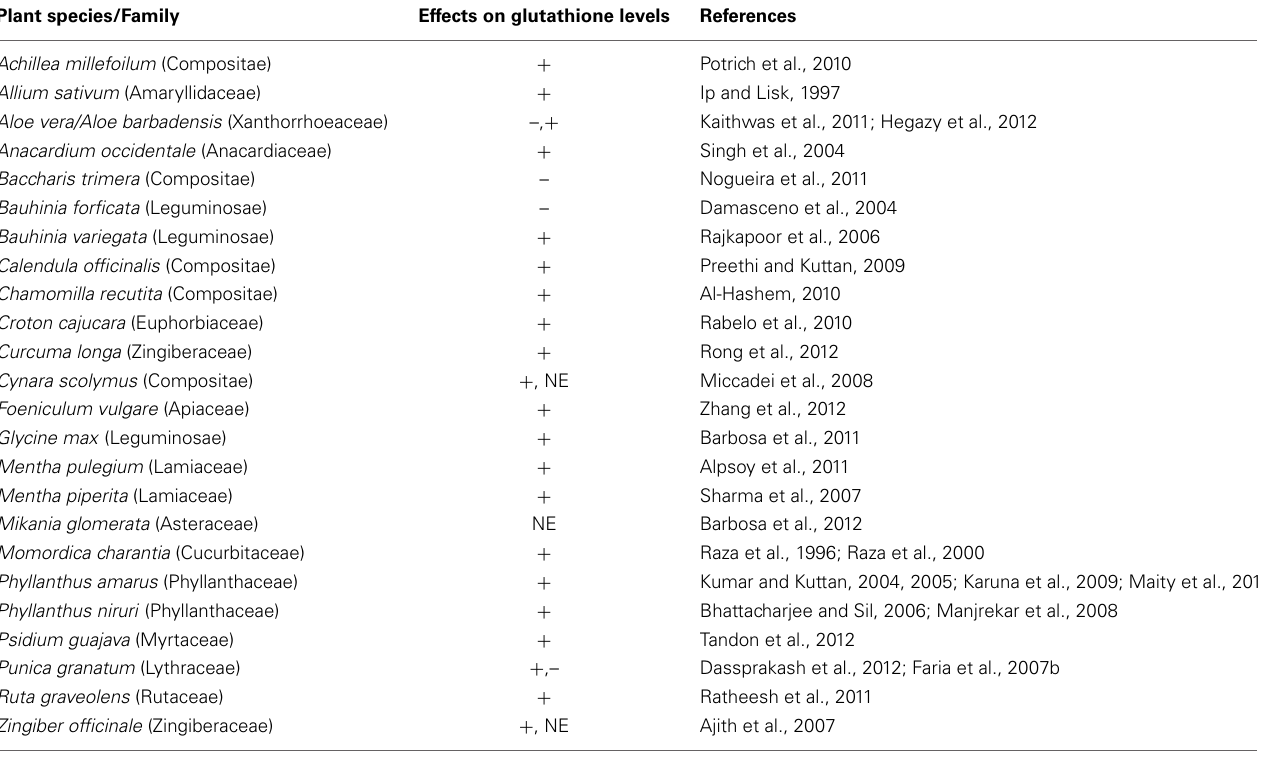
Table 7 | Medicinal plant species listed in RENISUS with reported effects of on glutathione levels. Plant species/Family